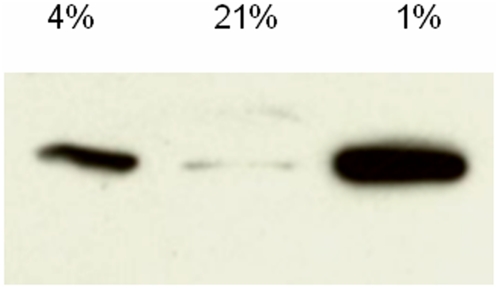
Hypoxia influences on Hif-1α.Whole cell lysates of OLs cultured in 21%, 4% or 1% O2 for 6 hrs. Cell lysates were immunoblotted for Hif-1α (120 kDa). 50 ug of protein per lane. Data shown are representative of three such studies.